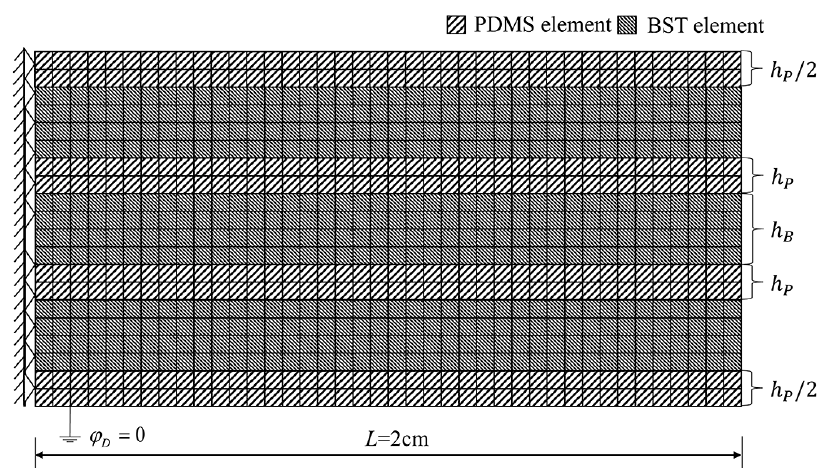
Figure 4. Schematic diagram of micro scale flexoelectric laminated energy collector. From the variation law of the output voltage of the structure with BST thickness shown in Figure 5, it can be seen that the numerical solution is in good agreement with the analytical solution; as the thickness of the BST layer increases, the output voltage of the overall structure increases first and then decreases; The output voltage of the composite beam structure reaches the maximum value when the thickness of the BST layer is 3 µ m, and the error between the numerical solution and the analytical solution is about 0.7%, which is within the acceptable range.